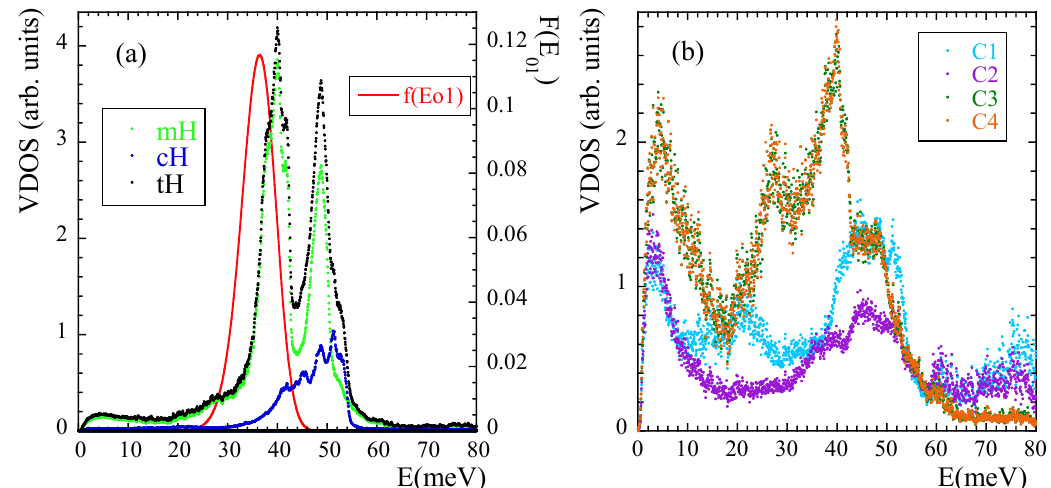
Figure 12. Vibrational density of states calculated at 25 K for mH, cH and tH ( a ) and for the different carbons [C1: methylene cC; C2: quaternary cC; C3 and C4: mC] ( b ). The line in ( a ) represents the librational peak F ( E 01 ) deduced within the 3-fold approximation from the distribution of activation energies obtained from the analysis of the functions F rel s ( Q , t ) at high